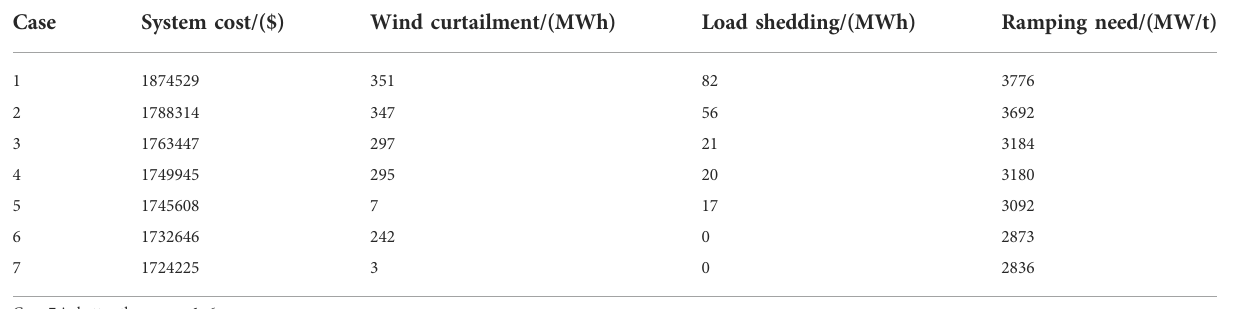
TABLE 7 Comparison of different